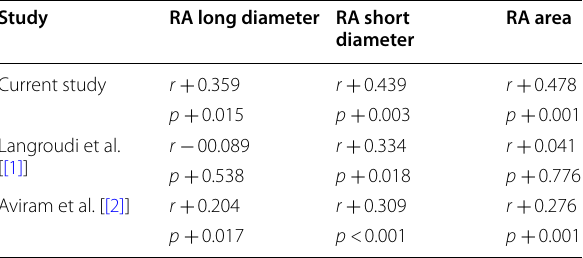
between the PAOI and radiologic parameters of right atrium in current and related previous